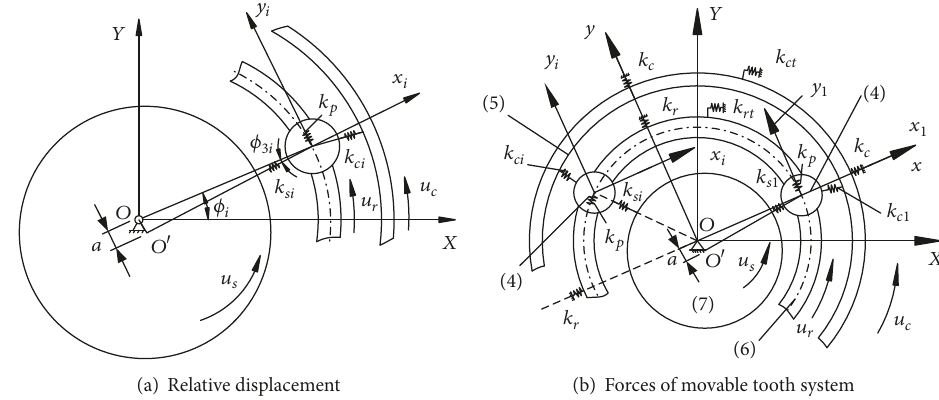
(b) Forces of movable tooth system Figure 3: Dynamic model of drive system of movable tooth piezoelectric